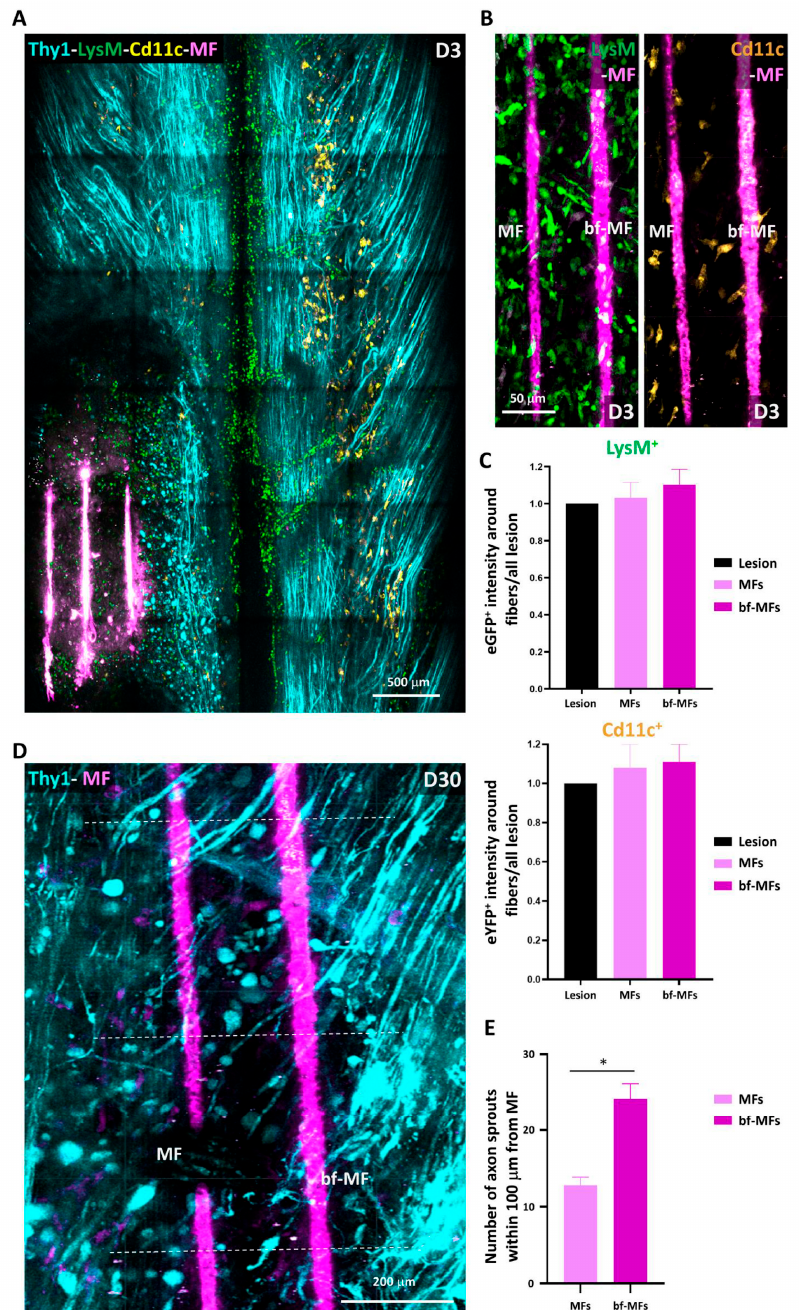
Figure 6. Biocompatibility of carbon microfibres and the effect of protein-coating. ( A ) Representative maximal intensity projection 2P images obtained in vivo three days after PUDQL followed by implan- tation of Microfibres (MFs, pink). Note the only mild accumulation of inflammatory cells inside the lesion. ( B ) Even distribution of LysM+ and CD11c+ in the vicinity of MFs three days after PUDQL. Note the absence of accumulation on the surface of MF in the presence (bf-MF) or absence (MF) of protein coating. ( C ) Average fluorescence intensity of EGFP or EYFP in a 100 µ m box centered on the MFs. Fluorescence was normalized to the average level encountered in the whole lesioned area. (n bf = 13, n bare = 9 out of 7 mice) ( D ) High magnification image of the lesion site 30 days after PUDQL. Axon density was higher in the vicinity of coated MFs (bf-MF) than non-coated ones (MFs), in particular at levels where axons sprouts were counted (dotted lines). ( E ) Average number of axons sprouts counted within the first 100 µ m from the bf-MF or MF surface. Data are shown as mean ± SEM (n bf = 11; n bare = 6).* p <